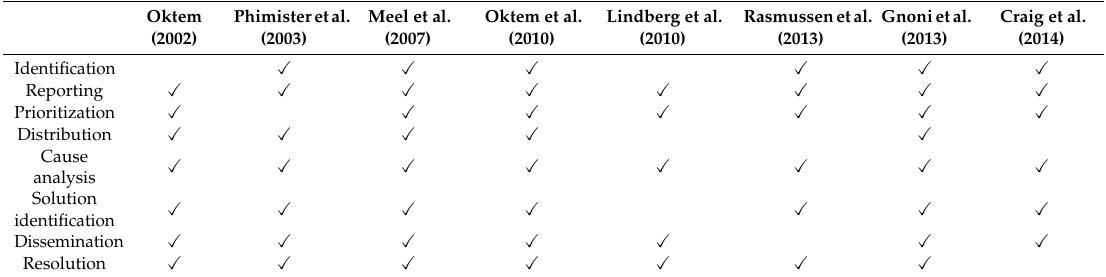
Table 1. Comparison of near-miss management systems found in the literature.